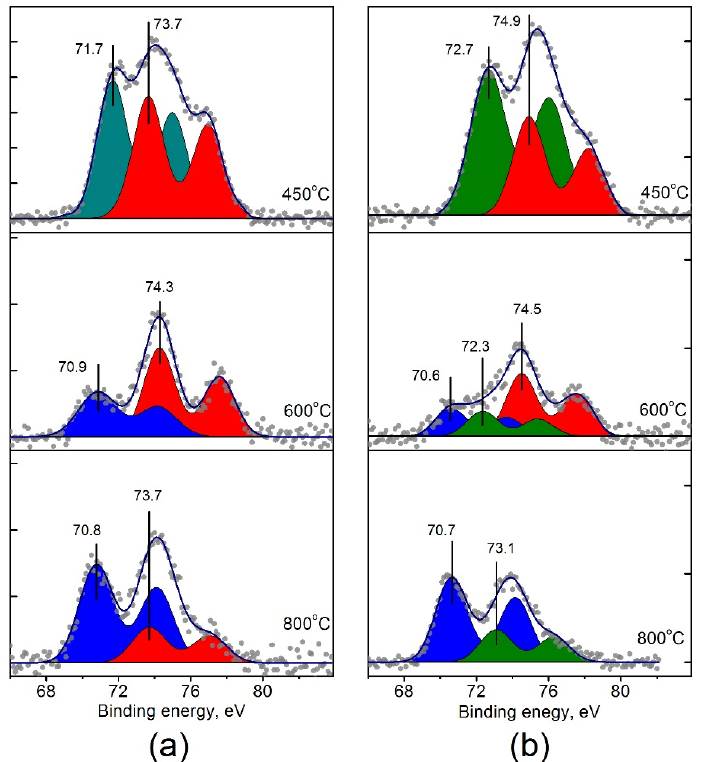
Figure 8. Curve-fitted Pt4f XPS spectra for ( а ) Pt/Ti-PLA and (b) Pt/Ti-P25 catalysts, calcined at 400 ° С , 600 ° С and 800 ° С . 600 ◦ C and 800 ◦